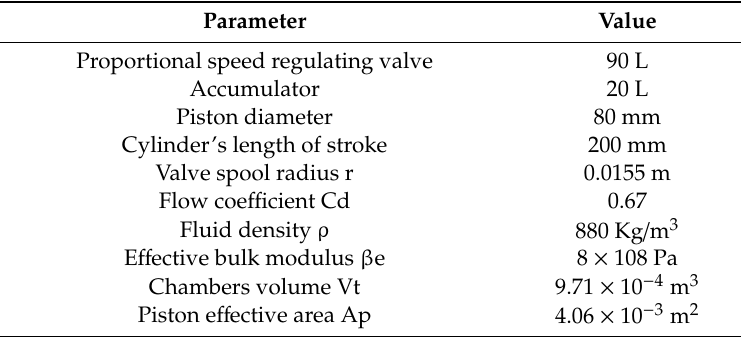
Table 1. Main parameters of the simulation model.